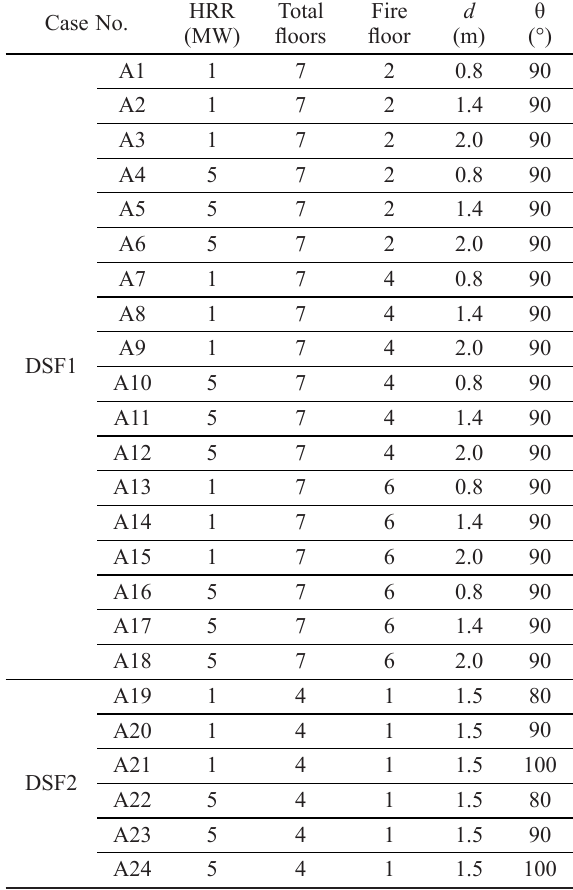
Table 1. Condition of numerical simulations Case